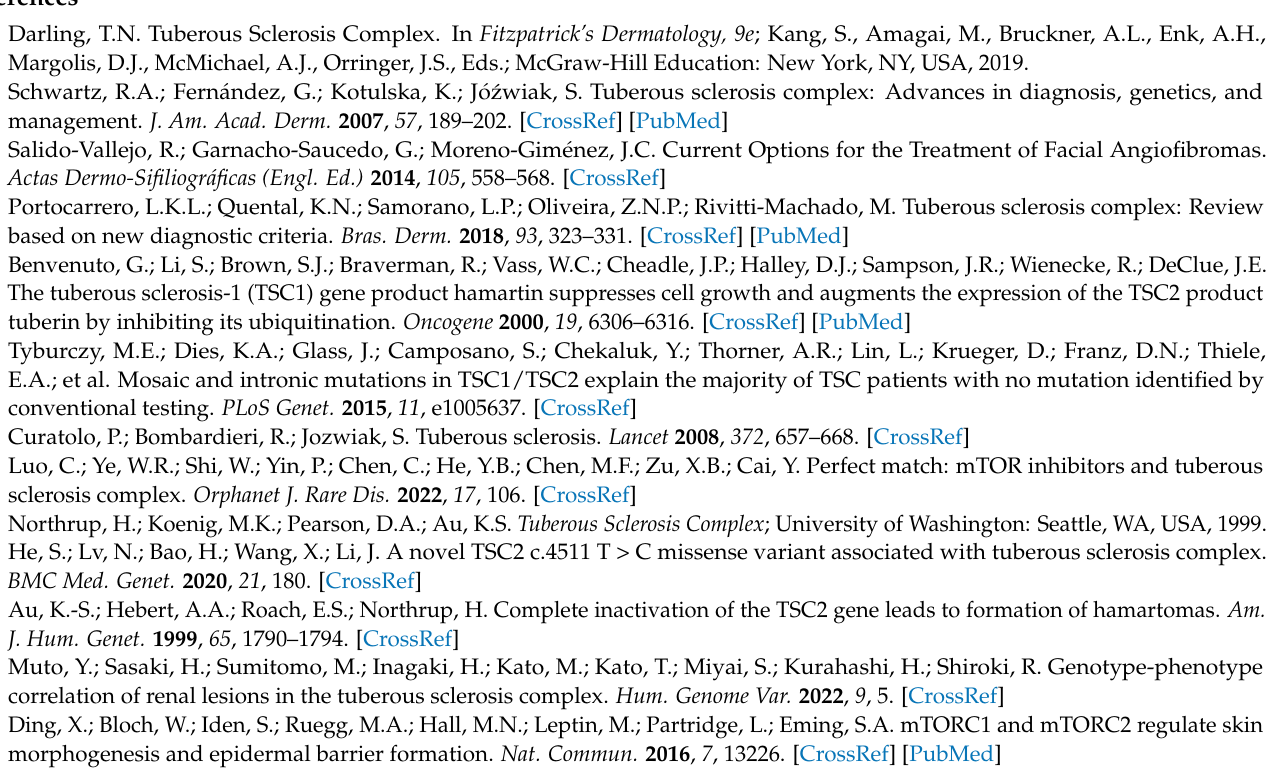
curve (SUCRA) of clinical improvement. Table S4: Surface under the cumulative ranking curve (SUCRA) of treatments based on severe adverse events leading to withdrawal. Figure S1: Summary for risk of bias of included clinical trials. The green symbols represent low risk of bias, the yellow symbols represent unclear risk of bias, and the red symbols represent high risk of bias. Figure S2: Forest plots of network meta-analysis of treatments for facial angiofibroma: analysis based on severe adverse events leading to withdrawal. Figure S3: Clinical improvement. Forest plots from pairwise comparisons of treatment agents. The result of a single study was identified as direct evidence when pairwise meta-analysis for a specific comparison was not attainable. Figure S4: Severe adverse events leading to withdrawal. Forest plots from pairwise comparisons of treatment agents. The result of a single study was identified as direct evidence when pairwise meta-analysis for a specific comparison was not